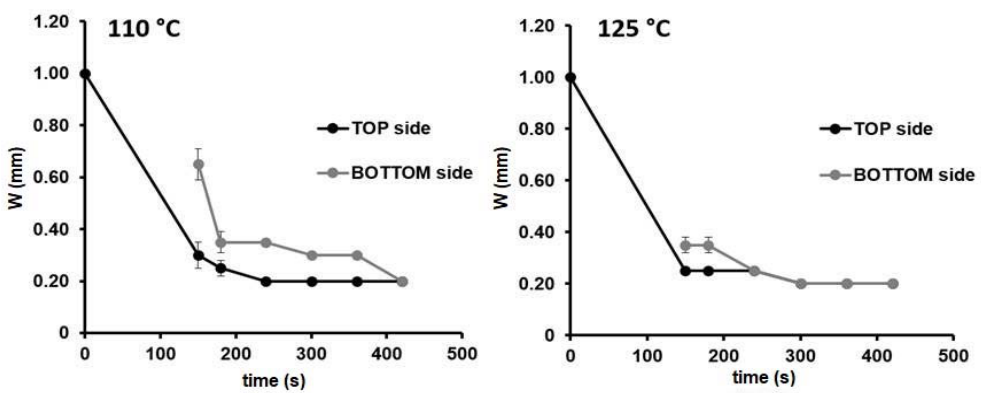
Figure 1 . Width changes over time in the front (black) and back (grey) sides of the paper substrate for the microfluidic paper-based analytical device (µPAD) configuration: device-5 (W c = 1.00 mm) during the heating process at 110 and at 125 °C, n = 3.